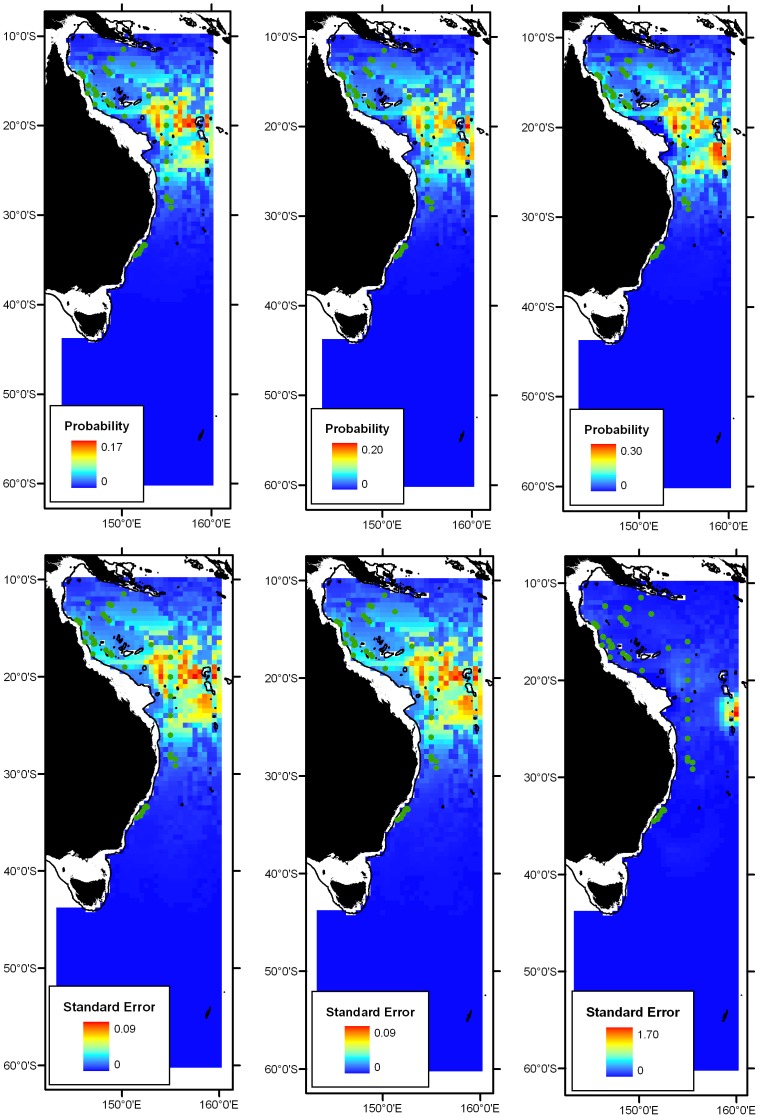
Predicted distributions of for Diaphus luetkeni (top row) and standard errors (bottom row).From left to right: 0 m, 150 m and 500 m depth envelopes. Green dots indicate all occurrence records of D. luetkeni.